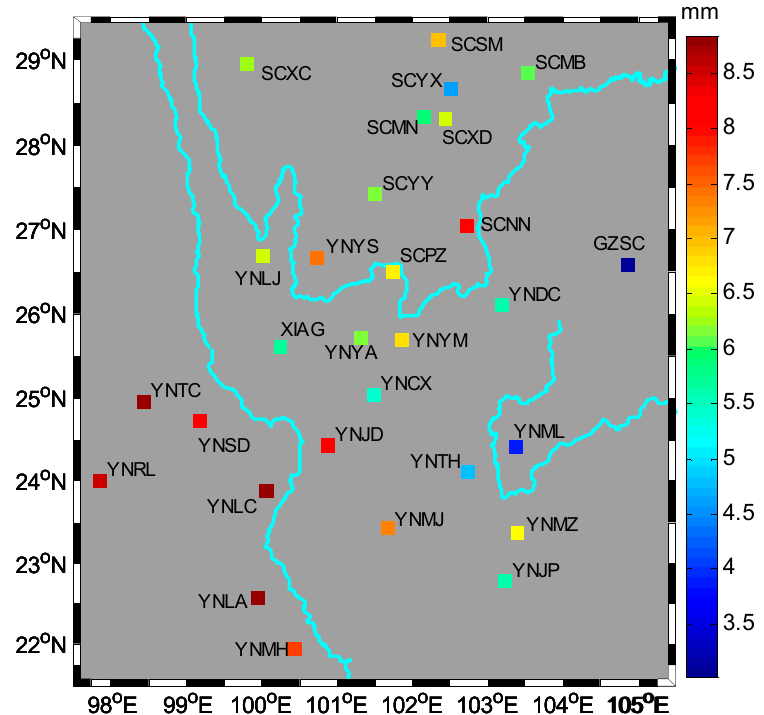
Figure 4. Annual amplitudes of the vertical positions at the 29 stations estimated by maximum likelihood method, the noise model is power law plus white noise.